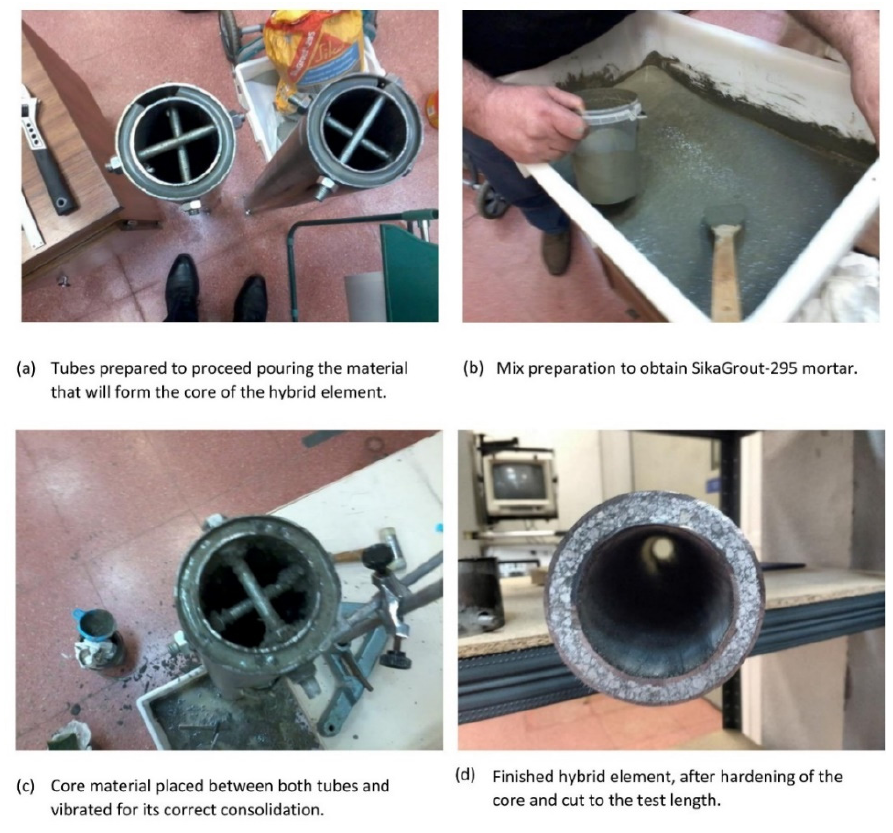
Figure 2. Manufacturing of a hybrid element with mortar core: ( a ) Preparation of steel tubes, ( b ) Kneading of SikaGrout-295 filler material, ( c ) Filling of filler material, ( d ) Finished hybrid element.